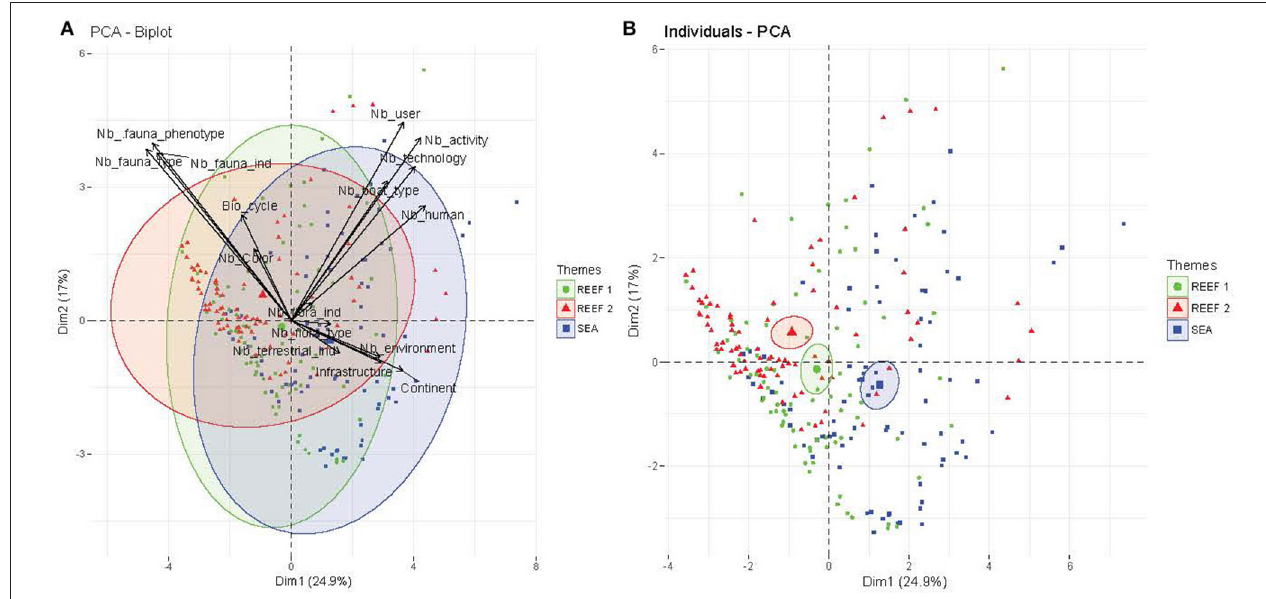
FIGURE 2 | Analysis of 248 drawings and 16 quantitative variables with Principal Component Analysis (PCA) (see Table 3 for the listing of the variables). (A) Individuals (drawings) vs. variables that explain the two first axes; the ellipses delimit 95% of the individuals of each drawing’s theme: Sea (blue), Reef1 (green, before MARECO), and Reef2 (red, after MARECO). (B) Individuals (drawings) and barycenter of the clouds of points with their confidence interval (confidence ellipse).